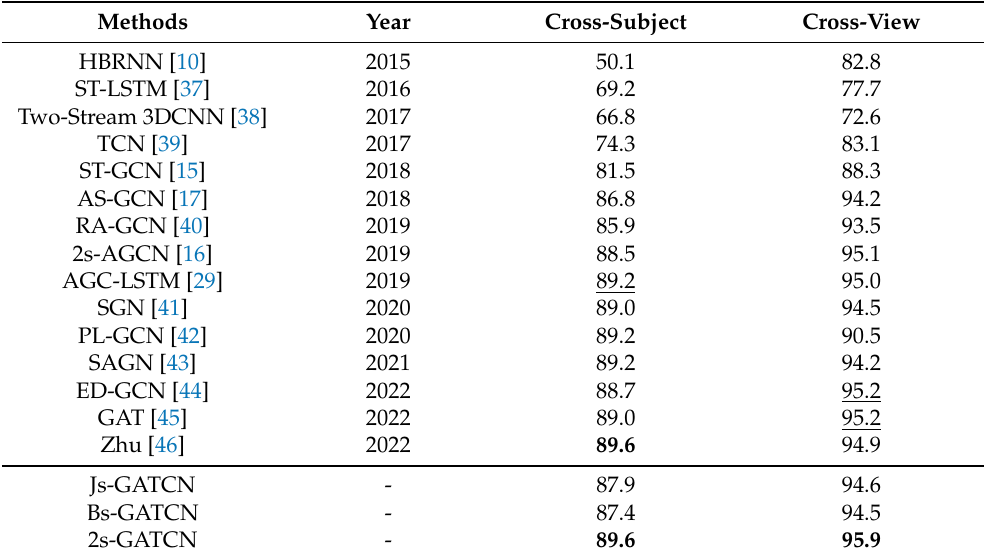
Table 3. Comparisons of the validation accuracy with state-of-the-art methods on NTU-RGB+D 60 dataset.